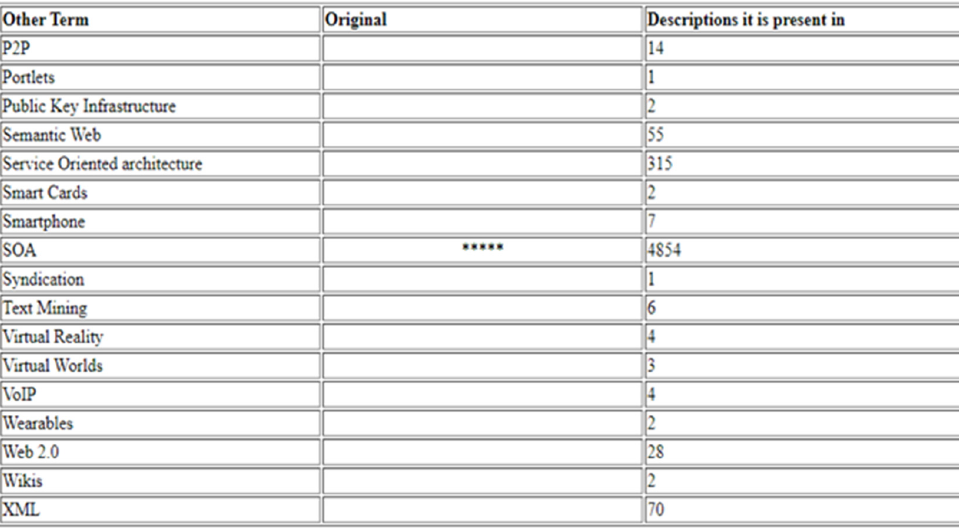
Figure 14. Graphical representation of relationships. Only primary relationships are shown (i.e., technology topics directly related to the technology topic of interest). If the second level is added (topics related to that first set of topics), the diagram becomes significantly more complex. The graph generation technology used does allow interactive browsing and so explo- ration of the full network is possible (as opposed to the simple hierarchical view shown in Figure 14).